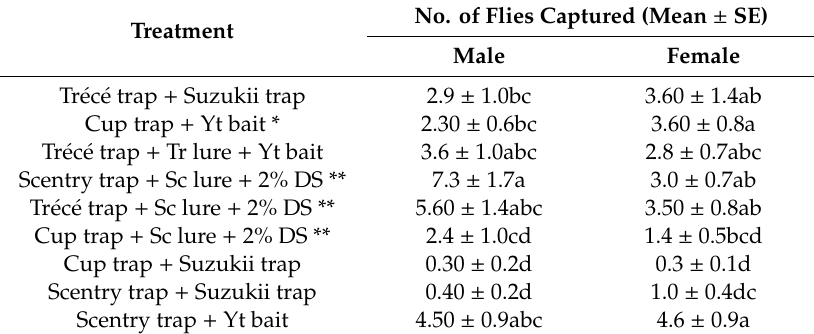
Table 3. Mean number of male and female adults captured in a rabbiteye blueberry planting from 19 May 2016 to 23 June 2016 in Citra,